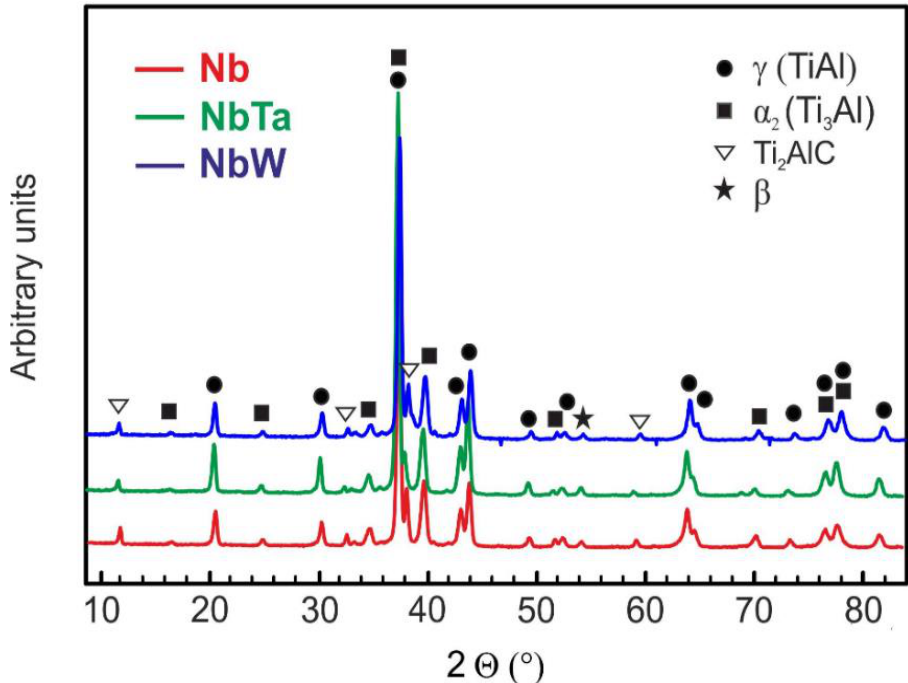
Figure 2. The typical XRD patterns of tilt-cast Nb, NbTa, and NbW alloys.